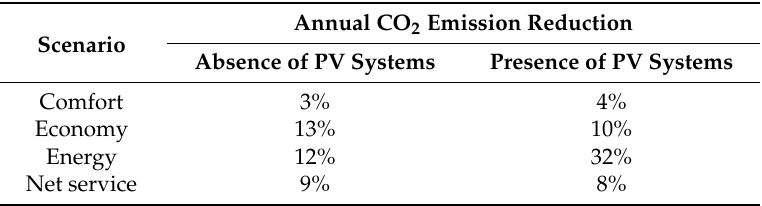
Table 14. Palermo—CO 2 emission reduction with respect to the traditional scenario